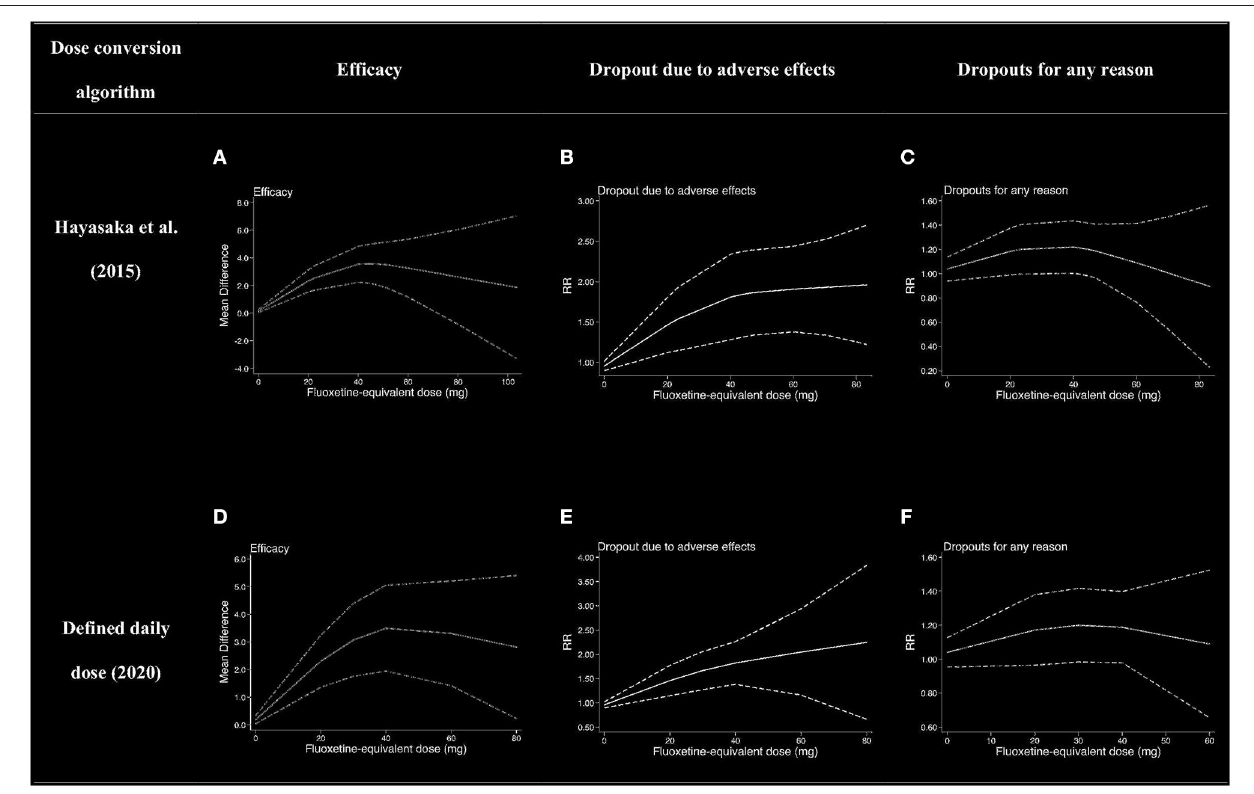
FIGURE 4 | Dose–outcome relationships for serotonin reuptake inhibitors (SRIs) in two dose conversion algorithms. RR, risk ratio. The dotted lines represent 95% CIs. (A–C) were the dose–outcome plots using the conversion method of Hayasaka et al. (31). (D–F) were the dose–outcome plots using the conversion method of defined